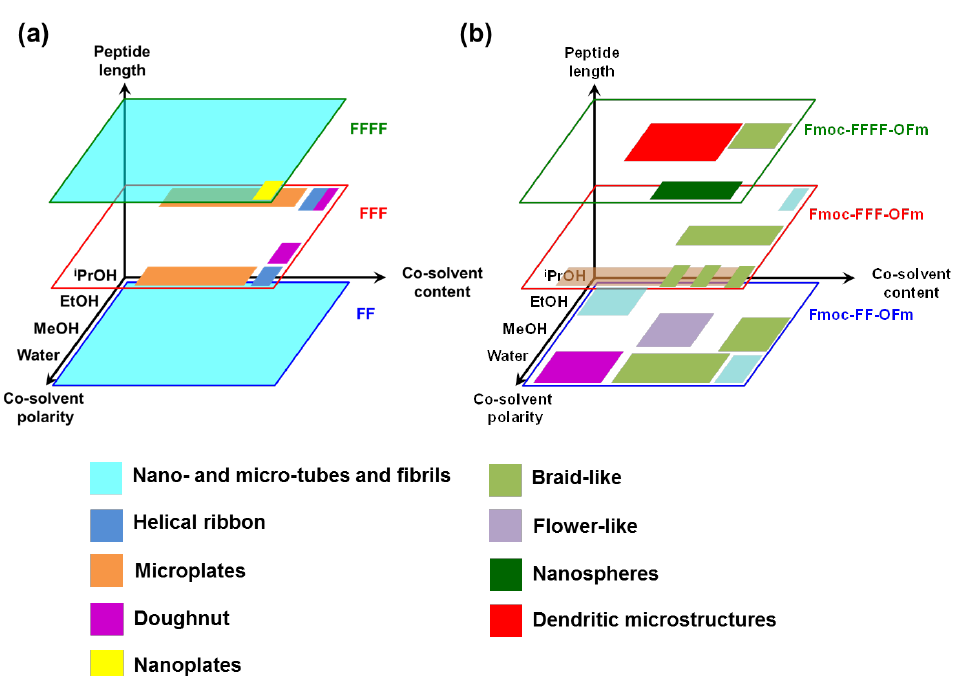
Figure 7. Sketches summarizing the assemblies formed by Phe-homopeptides as a function of the co-solvent, the amount of co-solvent (i.e., the peptide concentration) and the number of Phe residues: ( a ) uncapped and ( b ) capped at both the N - and C-terminus with fluorenyl groups.